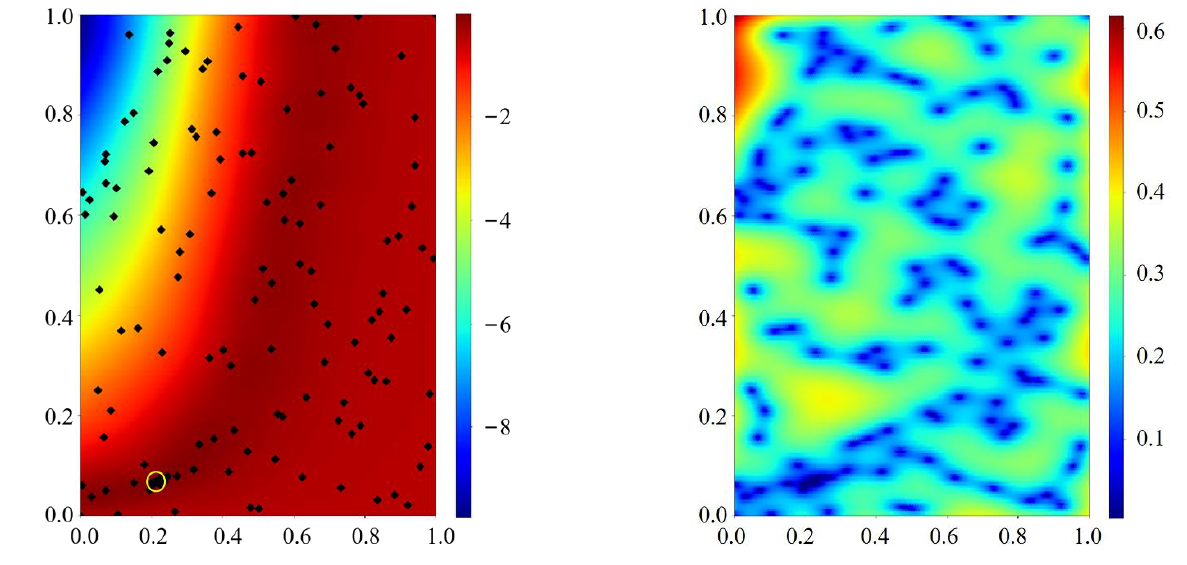
Figure A14. Two-parameter optimization process of ∆ k and m in the Houska model.